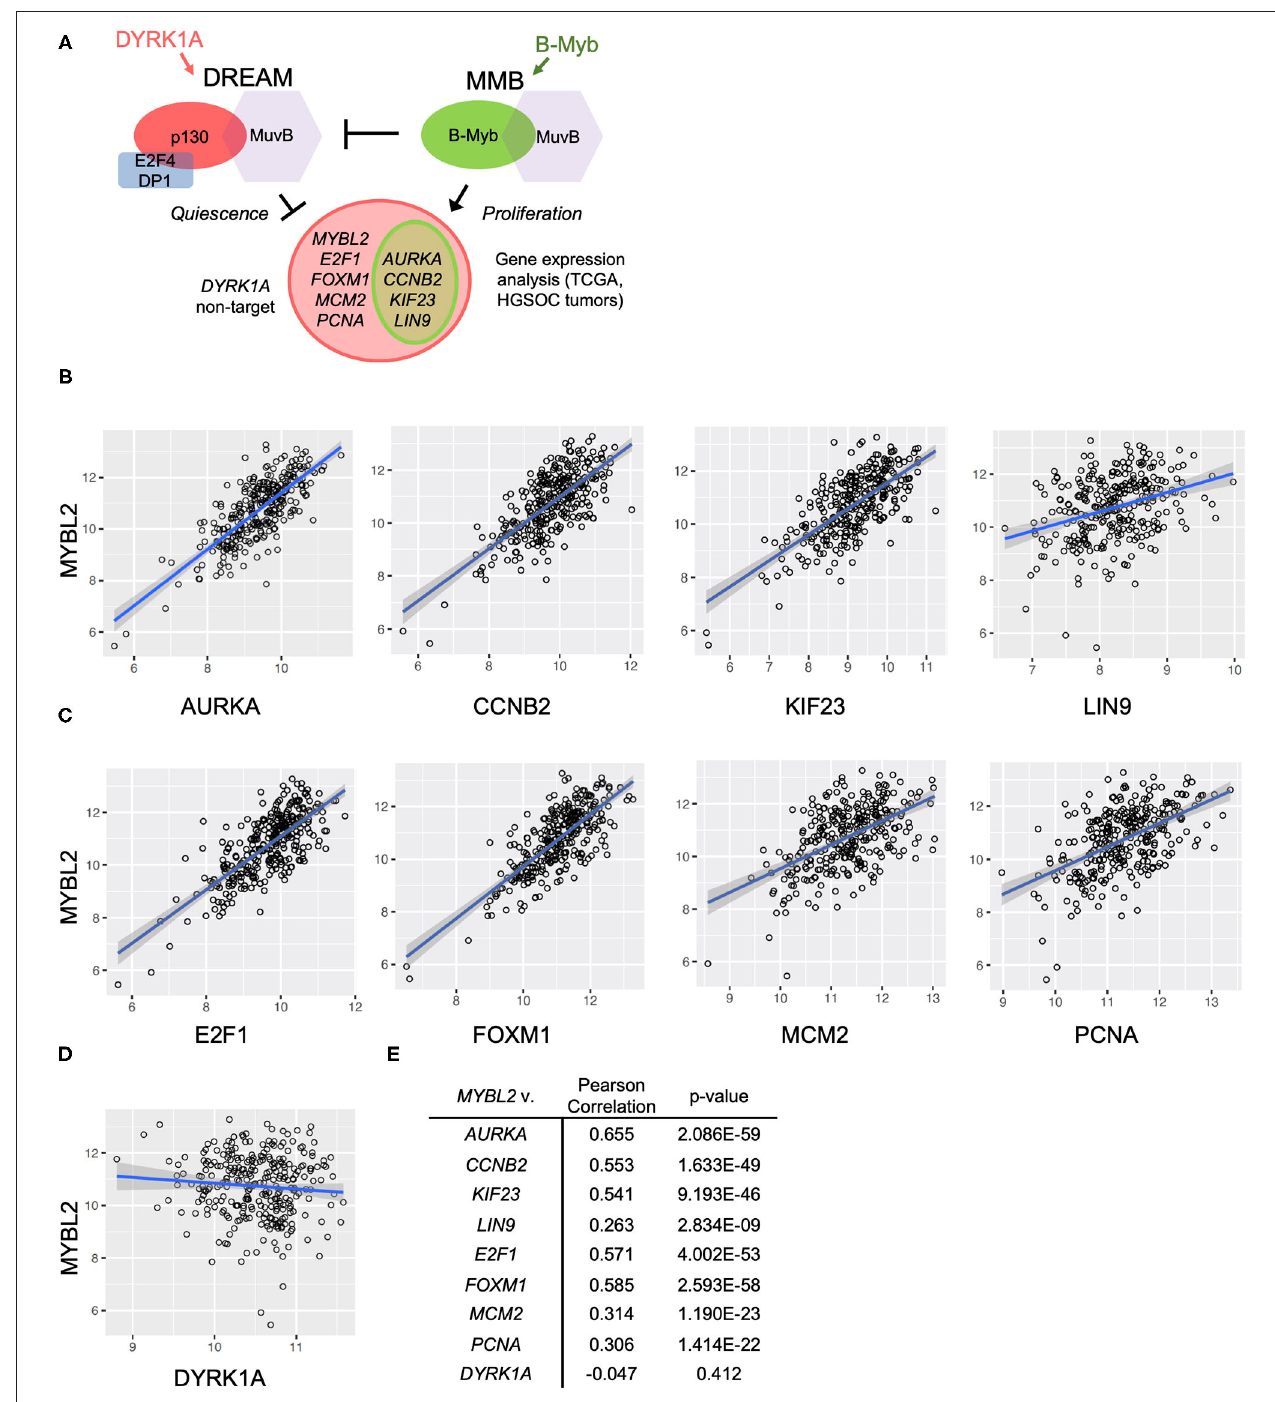
FIGURE 4 | MYBL2 expression correlates with DREAM target gene expression in the TCGA data set. (A) Model for B-Myb-mediated DREAM disruption. High B-Myb levels promote DREAM disassembly and, in turn, expression of genes normally repressed by intact DREAM. Genes of interest are shown along with control non-DREAM target gene, DYRK1A. Expression of DREAM target genes serves as a functional readout for DREAM formation. (B,C) HGSOC TCGA gene expression data relating MYBL2 expression to DREAM (B) and DREAM/MMB (C) target genes as well as non-DREAM/MMB target control DYRK1A (D) ( N = 303). (E) Results of TCGA Pearson correlations analyses and associated p